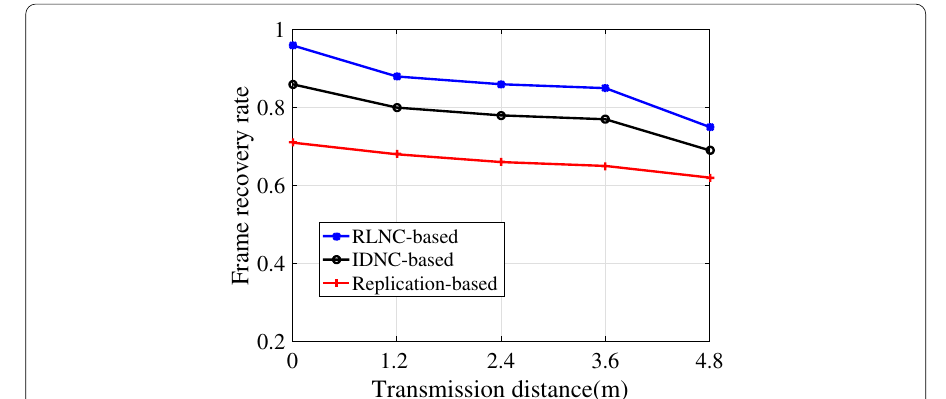
Fig. 16 The relation between transmission distance and frame recovery rate